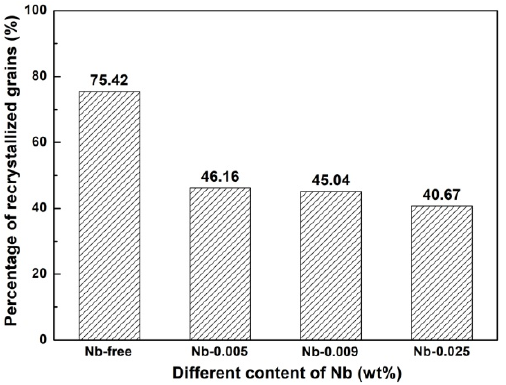
Figure 6. Percentage of recrystallized grains of hot-rolled bands with different Nb content.